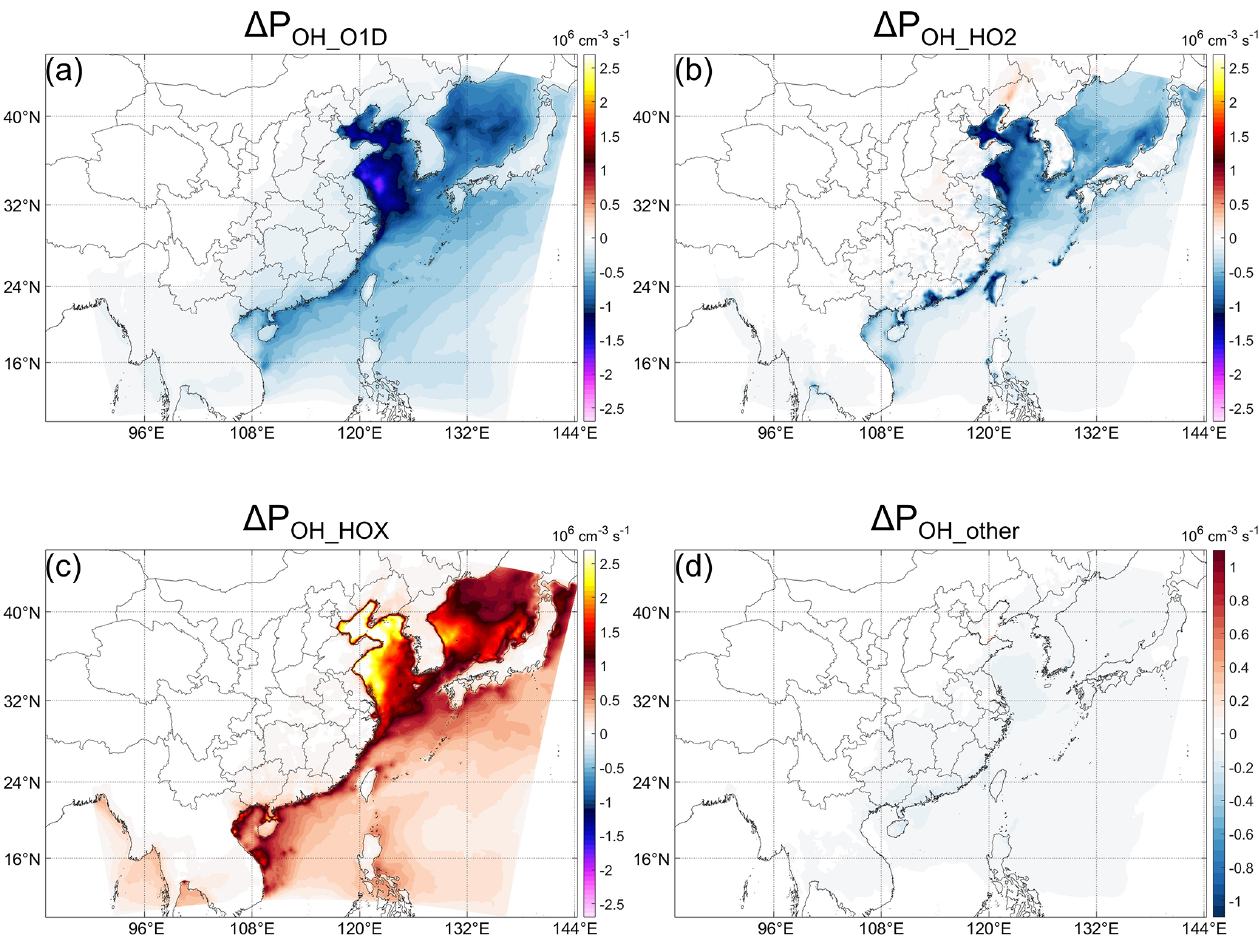
Figure 3. Decomposition of Fig. 2a for different pathways: change in P OH (All_high-BASE case) caused by the changes in (a) O( 1 D) ( (cid:49) P OH_O1D ), (b) HO 2 + Y ( (cid:49) P OH_HO2 , Y = NO, O 3 , etc.), and (c) HO X + h ν ( (cid:49) P OH_HO X ), as well as (d) other pathways (Fig. 2a minus the sum of a and c ). The red and blue color scales are the same in (a) – (d)